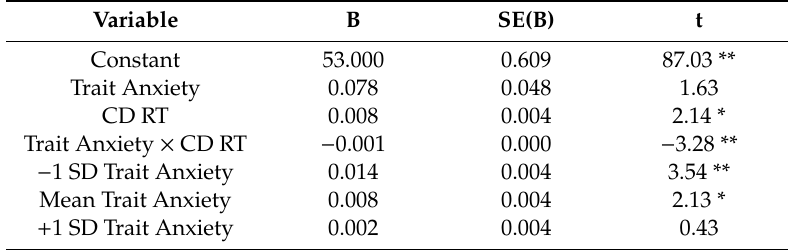
Table 2. Moderation by Trait Anxiety of the Relation between the Change Detection Reaction Time and O-Span